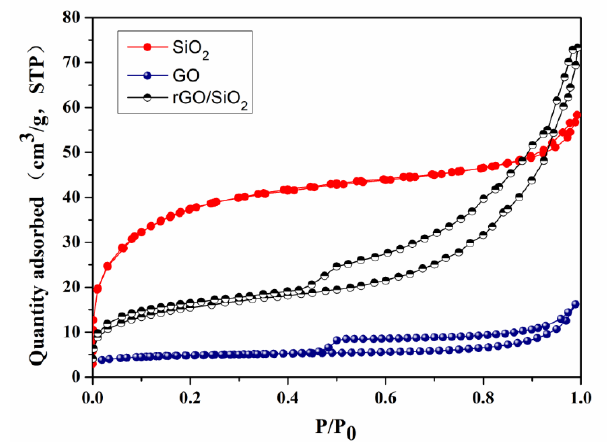
Figure 4. Nitrogen adsorption/desorption isotherms of the SiO 2 , GO and rGO/SiO 2 samples at 77 K.